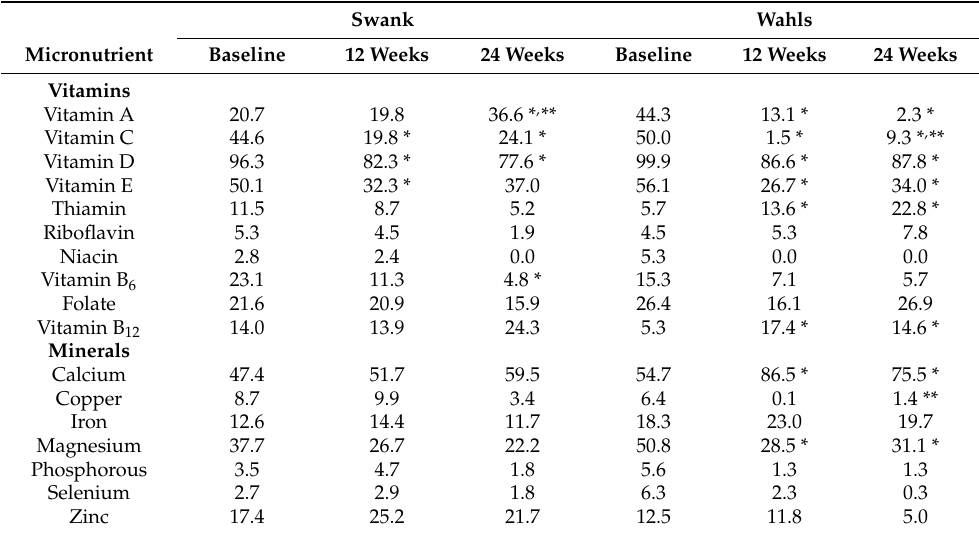
Table 4. Proportion with inadequate micronutrient intake from food at baseline and after adapting the Swank or Wahls diets among individuals with RRMS 1,2 . Swank Wahls Micronutrient Baseline